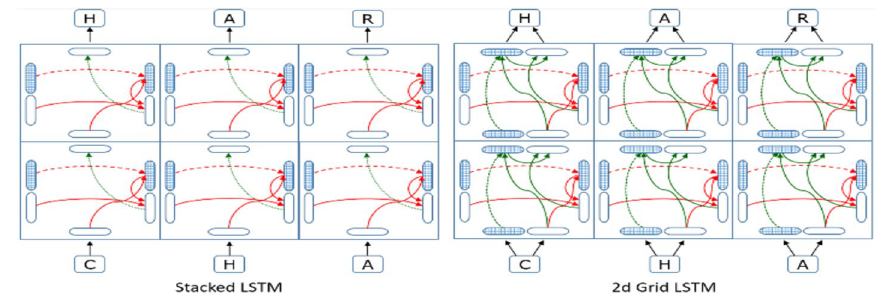
Fig. 19 Grid LSTM (right) versus Stacked LSTM (left)